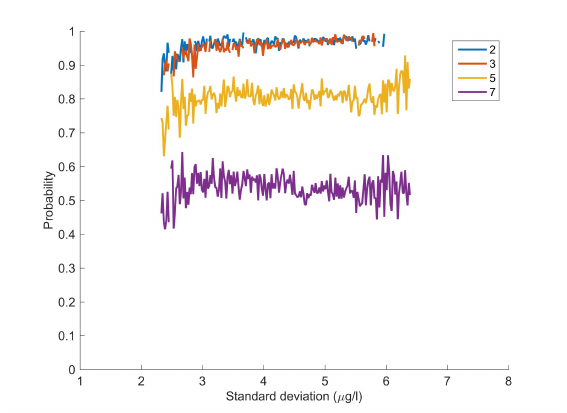
Figure 12. The probability that the RMSE < 4.0 is presented for different number of wavelength bands used as variables.12 randomly selected reference